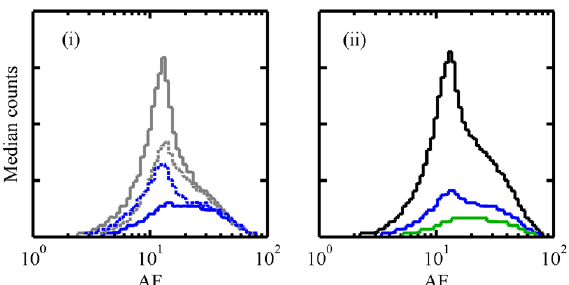
Fig. 3. Median asymmetry factor (AF) histograms (i) of N NON (grey) and N NADH (blue) during enhanced N NADH (dashed) and in- tervening periods (solid), and (ii) N TOT (black), N NADH and N TRY (green) through the period 22 to 29 June 2010.